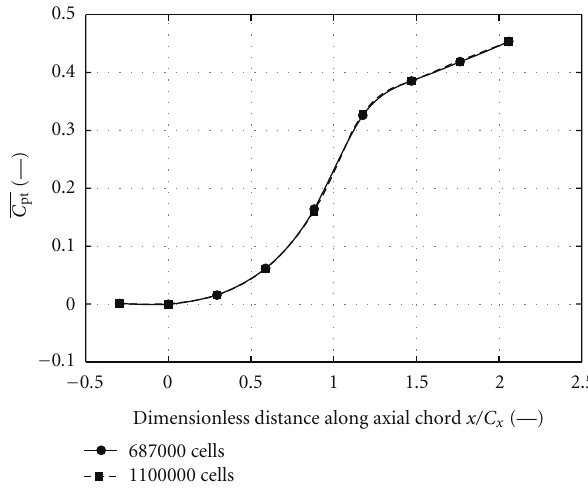
Figure 6: Mid-span deviation angle downstream of the blade.